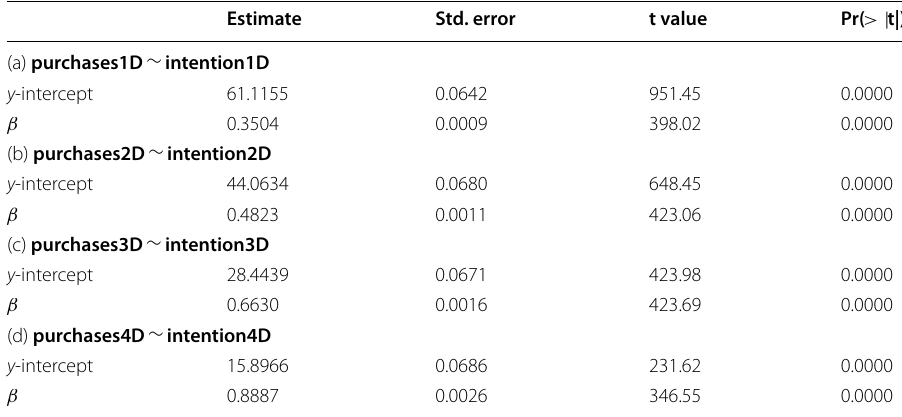
Table 6 Least squares linear regressions run for all values of I i on B i , baseline and modified values considered. β increases as more dimensions are considered Estimate Std. error